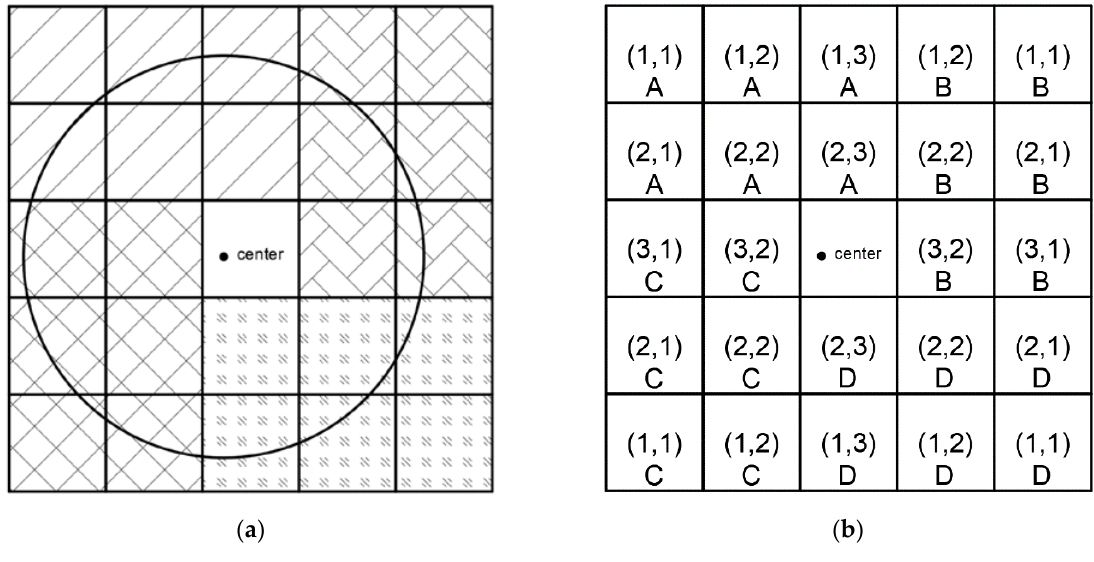
Figure 6. Cell sets for solid fraction calculation.